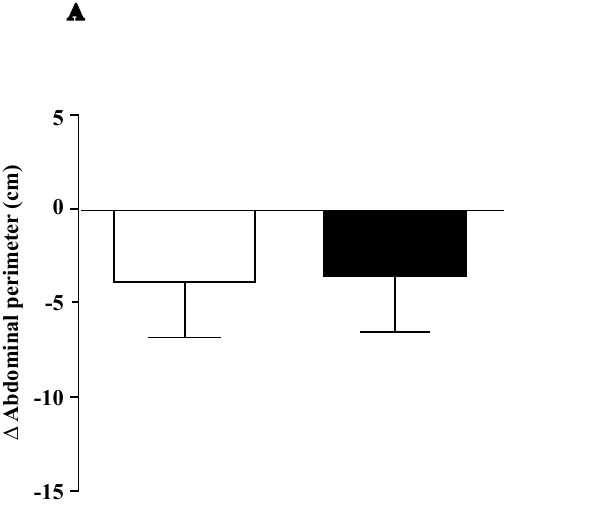
Figure 1 - Effect of the training program on the variation (delta) of abdominal circumference (figure 1A) and waist-hip ratio (figure 1B) in ovula- tory (OS) and postmenopausal (MN) women. Data are mean and standard deviation of the